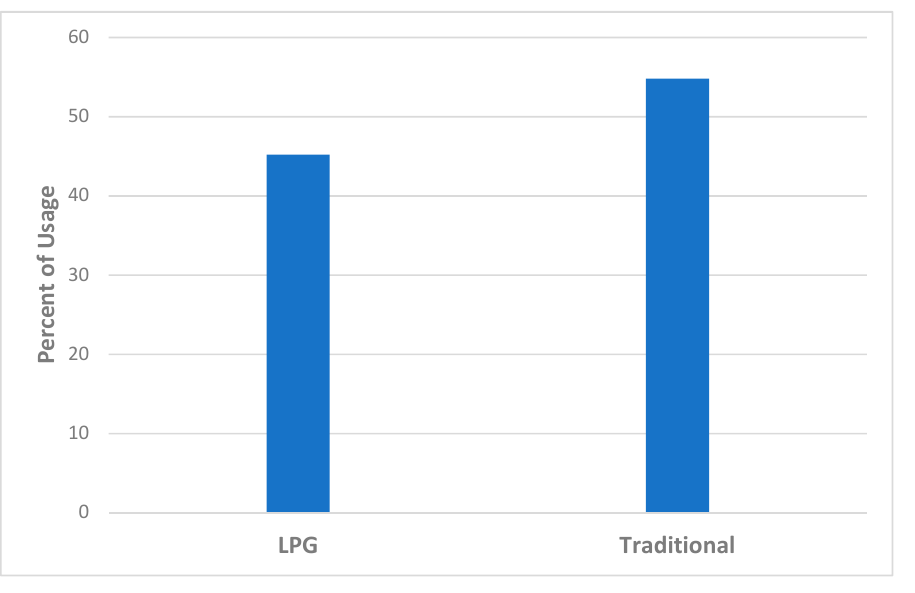
Figure 3. Percent of average LPG and traditional stove use per month for all study households over 18 months of monitoring. Tables 1 and 2 summarize results on exploring correlates of the proportion of LPG use (research objective 2). As depicted in Table 1, the proportion of LPG use varied little in the 18-months monitoring period of the study. Compared to the baseline average (Mean = 0.46, SD = 0.28), the midline LPG use almost remained the same (mean = 0.46, SD = 0.28). There was a further reduction in LPG use at the endline by nearly five percentage points (mean = 0.41, SD = 0.33). In terms of income, most households’ income fluctuated with each season—96.72% at baseline, 81.67% at midline, and 100% at endline. Interestingly,